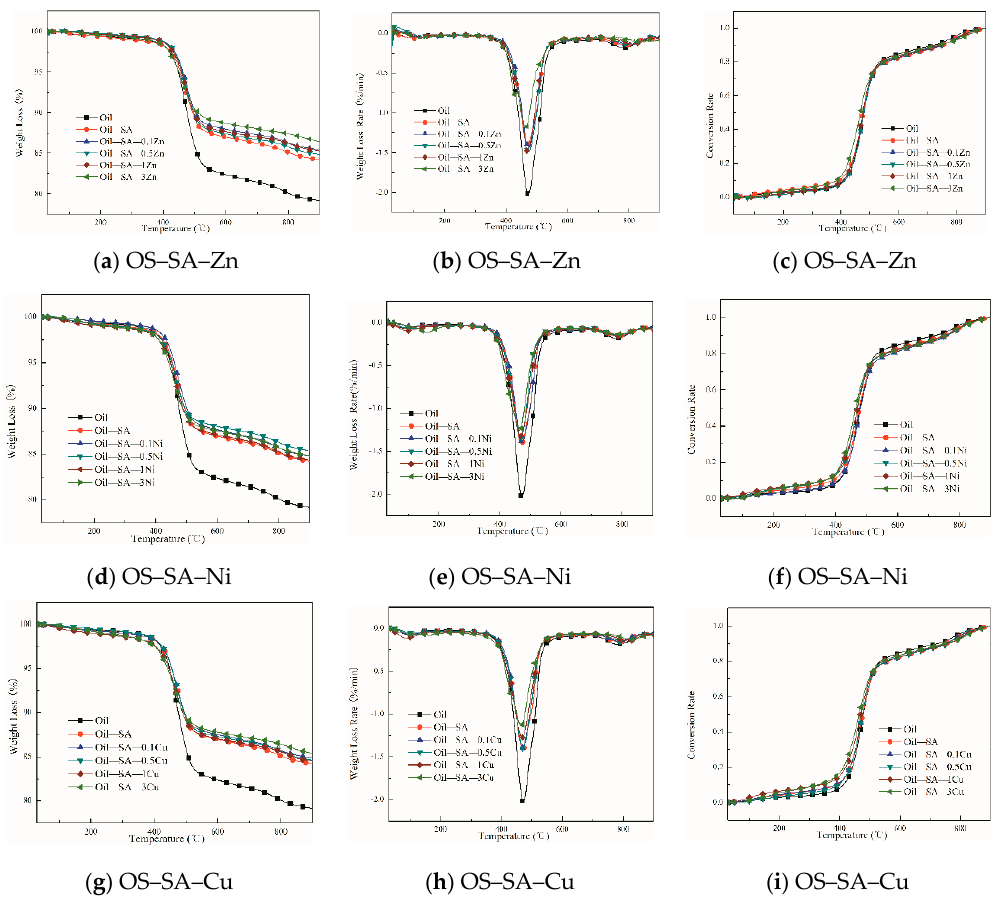
Figure 3. Thermogravimetric curves of OS under shale ash-based catalyst: ( a , d , g ) TG; ( b , e , h ) DTG; ( c , f , i ) conversion rate.